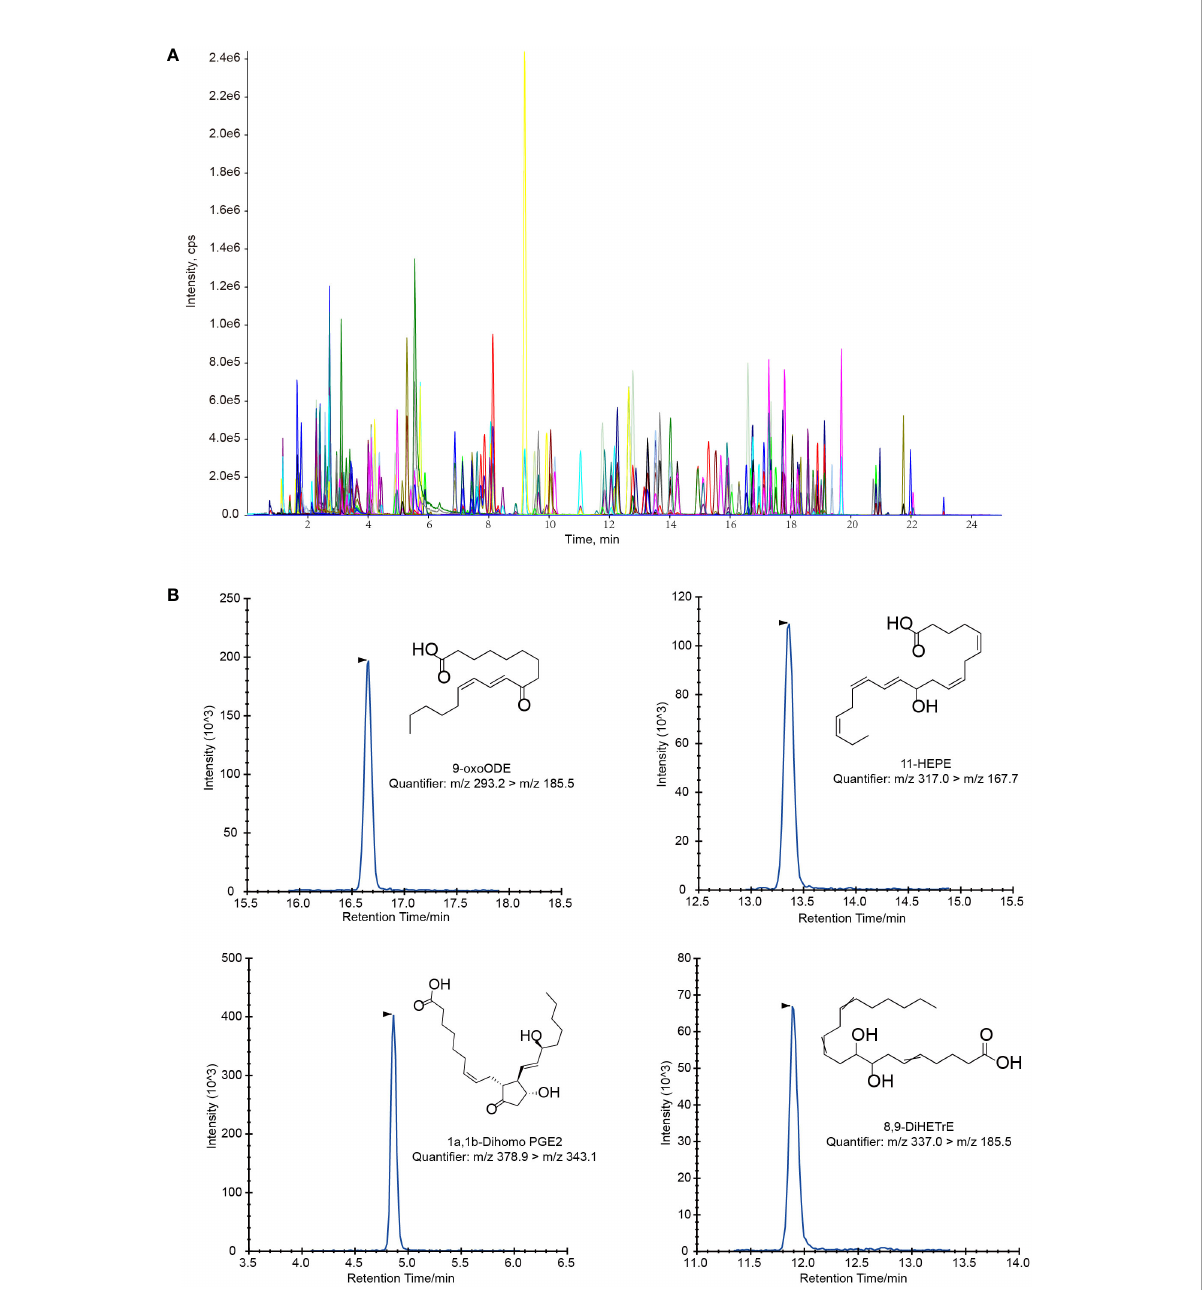
FIGURE 1 Extracted ion chromatograms (EIC) for oxylipin quanti fi cation. (A) LC-MS/MS chromatogram of a standard mixture of 128 oxylipins. (B) Several example of LC-MS/MS chromatograms of single oxylipin in magni fi ed